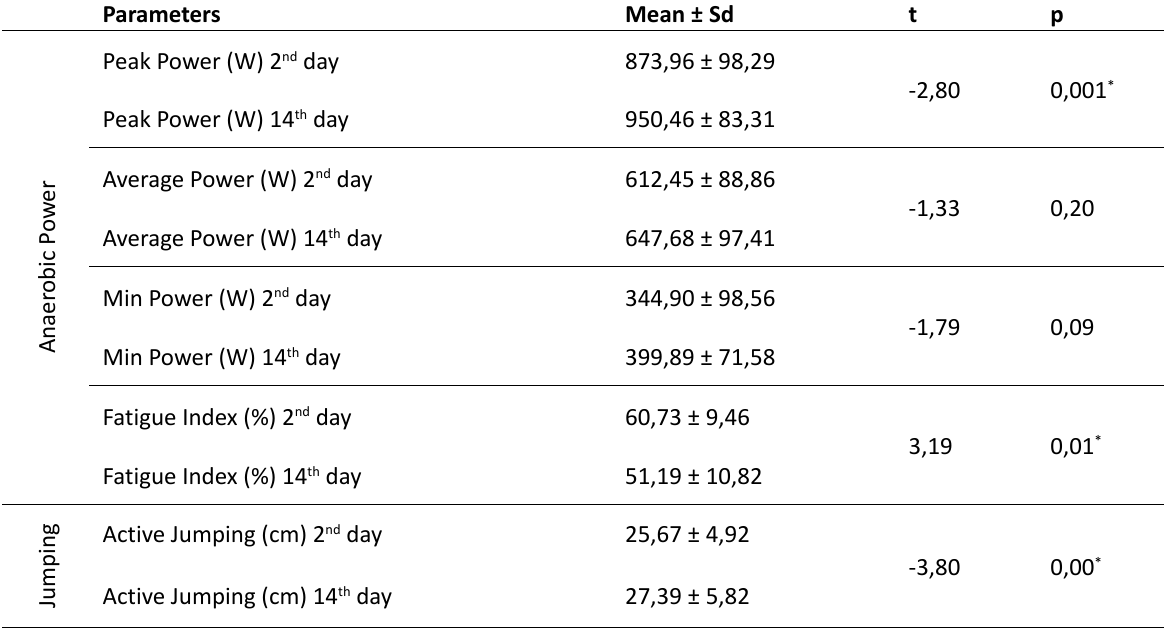
Table 2 . Anaerobic power and jump performance menstrual phase difference analysis table